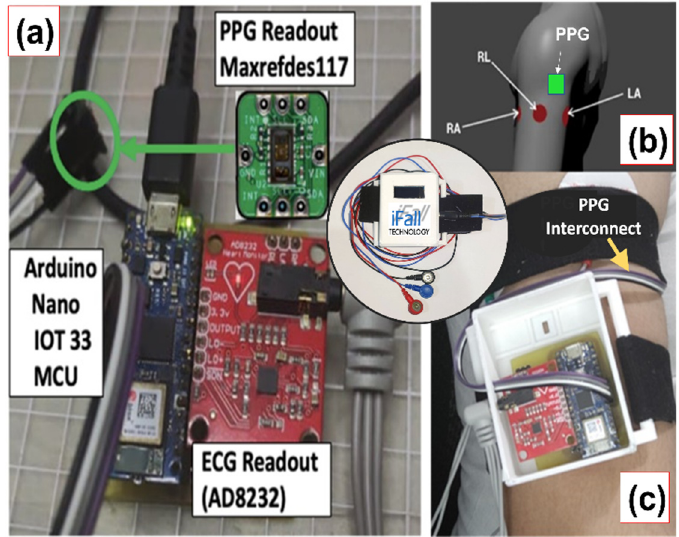
Figure 3. Fabricated device: ( a ) circuit overview, ( b ) electrode placement, ( c ) device placement onto the upper arm for data acquisition.